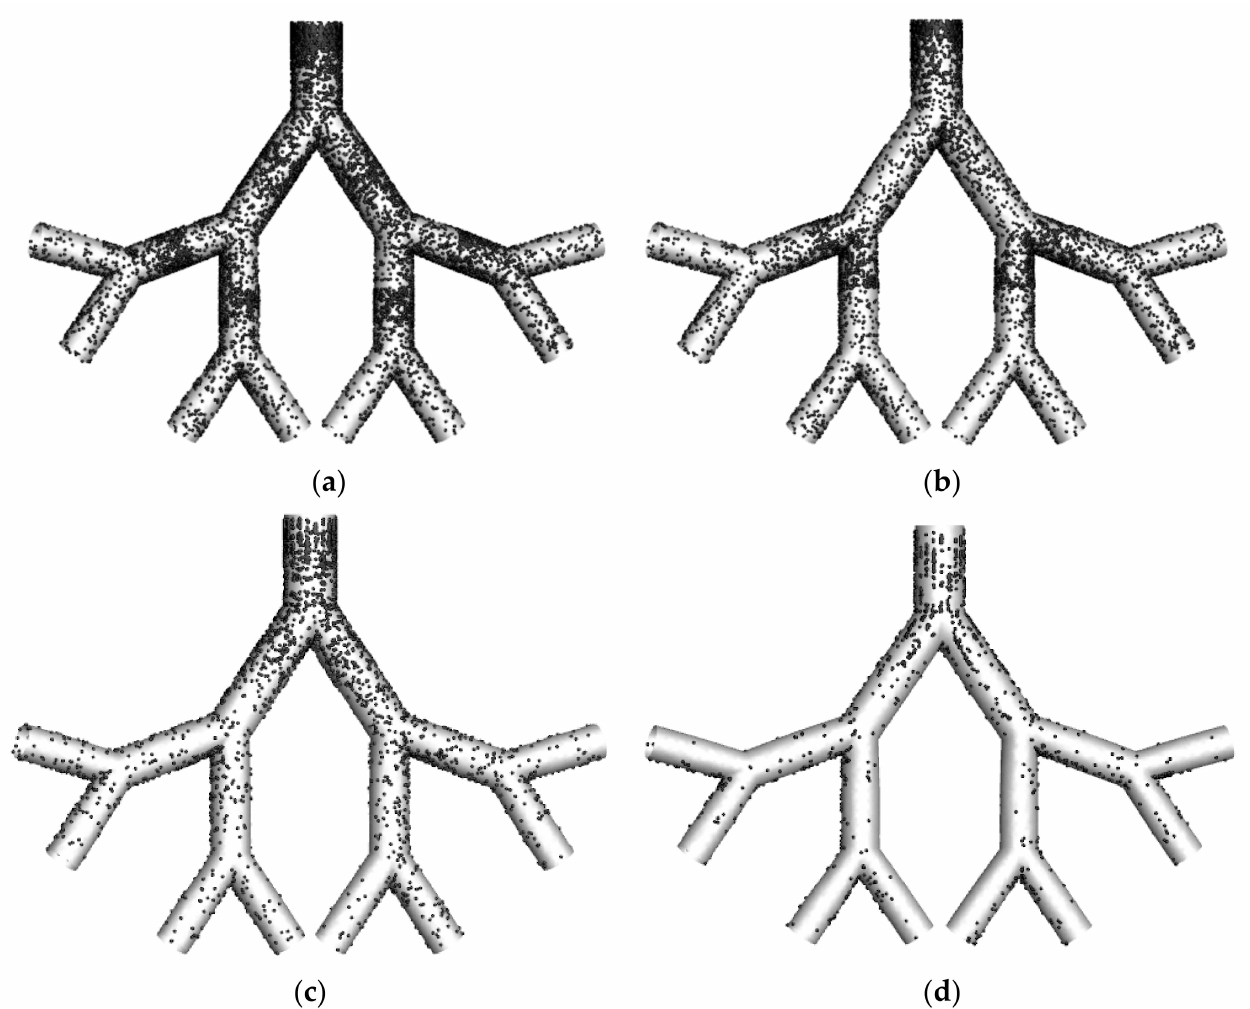
Figure 9. Visualization of particle deposition for the 30 years age for generation G12–G15 of the lung defined in Figure